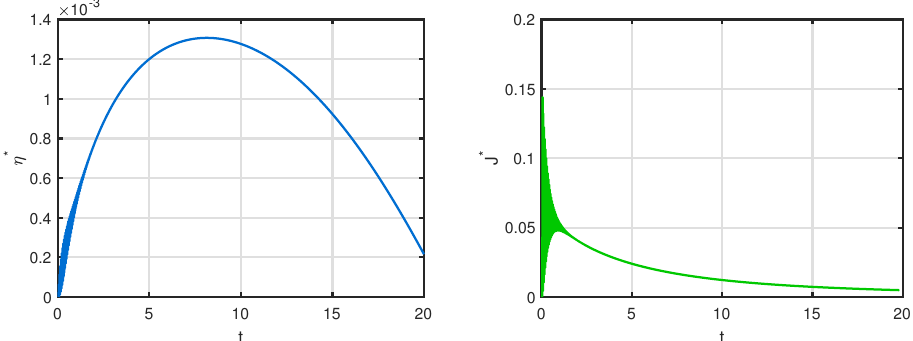
Figure 13. Time series of optimal control η ∗ and optimal cost J ∗ of system (26) for Table 6 when ε = 0.95 , ω 1 = 1.6, ω 2 =